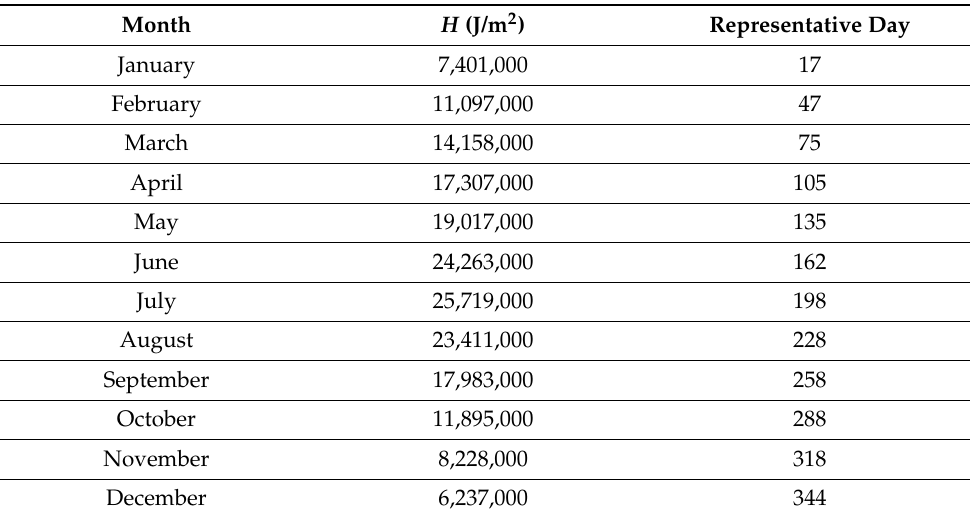
Table 1. Data considered for the estimation of the annual solar irradiance in “El Molino” PV Plant (Cordoba, Spain): horizontal daily radiation, H [48] and representative day proposed by [47] each month of the year.